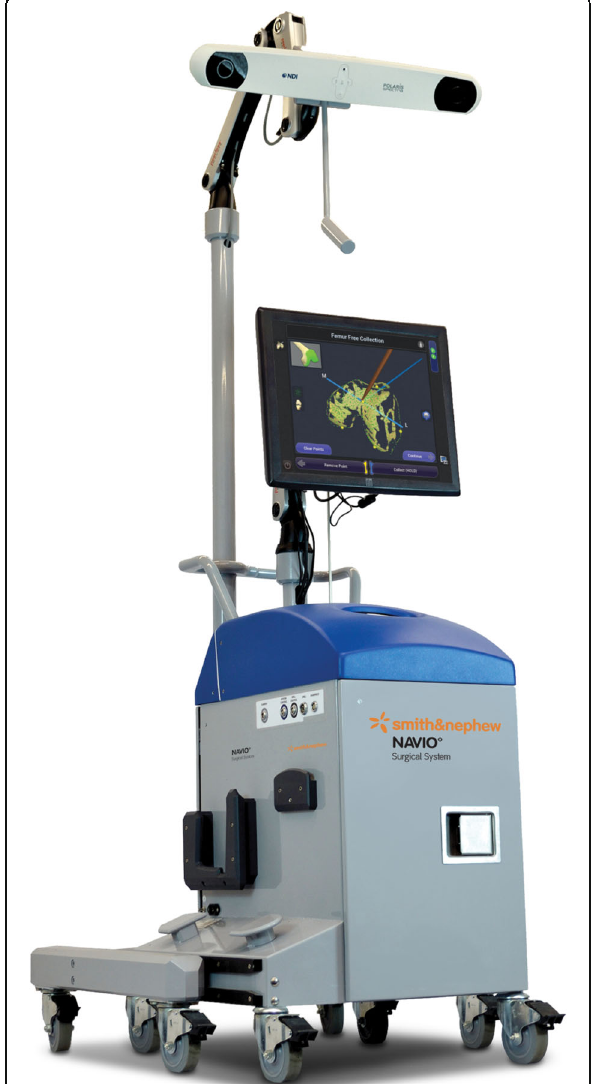
Fig. 2 NAVIO robotic system (Smith and Nephew) demonstrating the robotic unit with computer interface for surgeon feedback and motion capturing